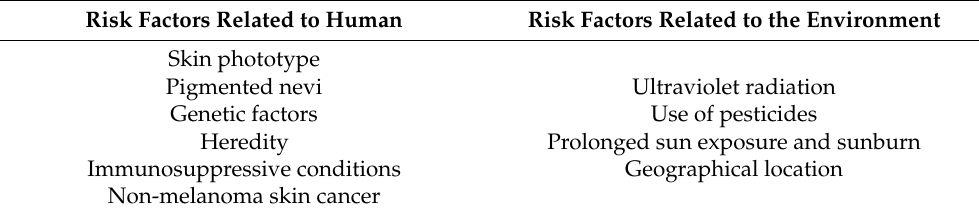
Table 1. Risk factors for the development of cutaneous melanoma (cM).